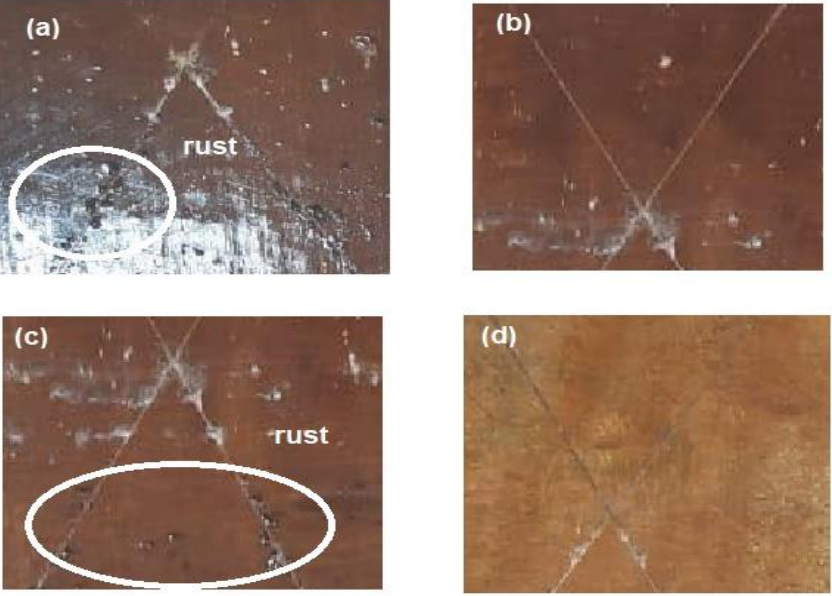
Figure 11. Salt spray resistance of DGEB / PAIIL coatings using di ff erent weight ratios ( a ) 1:1, ( b ) 2:1, Figure 10. Salt spray resistance of DGEB/PAIIL coatings using different weight ratios ( a ) 1:1, ( b ) 2:1, ( c ) 3:1 and ( d ) ( c ) 3:1 and ( d ) 4:1.